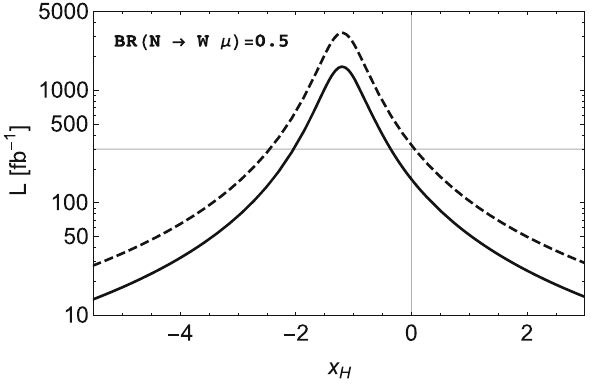
Fig. 4 The plot shows the luminosity required to obtain 25 signal events of the Z (cid:2) boson as a function of x H , for fixed values of the m Z (cid:2) = 3 TeV and BR ( N → W μ) (cid:6) 0 . 5. The solid line corresponds to m N 1 = m Z (cid:2) / 4 and m N 2 > m Z (cid:2) / 2, while the dashed line corresponds to m N 1 , 2 = m Z (cid:2) / 4. The vertical solid line marks the B − L limit ( x H = 0). The solid horizontal line corresponds to a luminosity value of 300 fb −